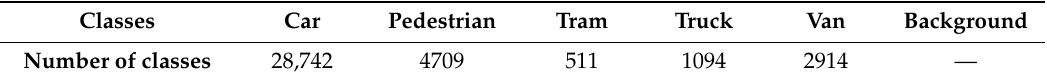
Table 1. Types and quantities of objects for Faster R-CNN